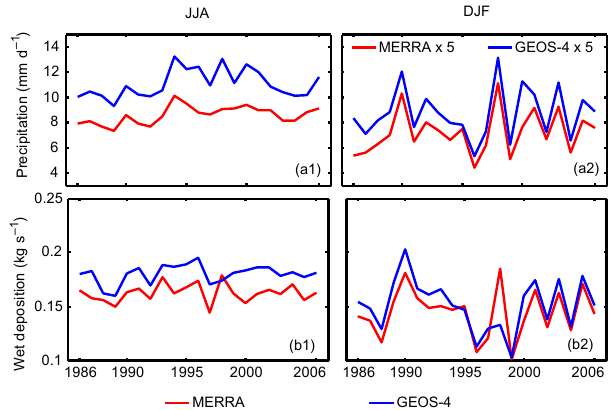
Figure 2. (a1) JJA and (a2) DJF mean precipitation (mmd − 1 ) aver- aged over eastern China for 1986–2006 from GEOS-4 (blue lines) and MERRA (red lines) meteorological data. DJF mean precipita- tion is multiplied by 5 in panel (a2) . (b1, b2) Same as panels (a1) and (a2) , respectively, but for wet deposition (kgs − 1 )